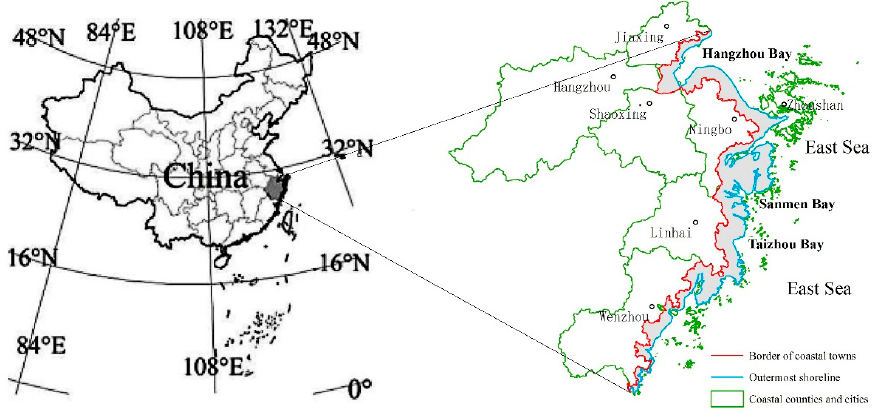
Figure 1. A sketch map showing the study area.